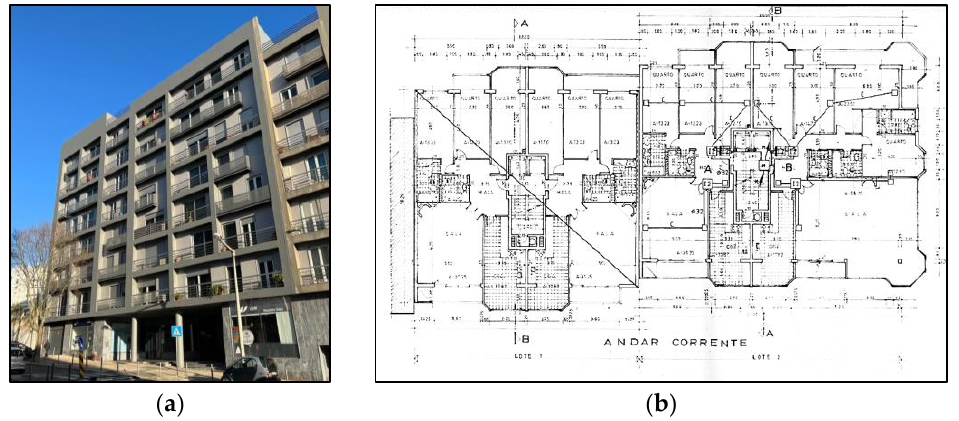
Figure 3. Modern buildings: ( a ) Modern RC building located in Benfica and ( b ) typical plan for this period of construction.